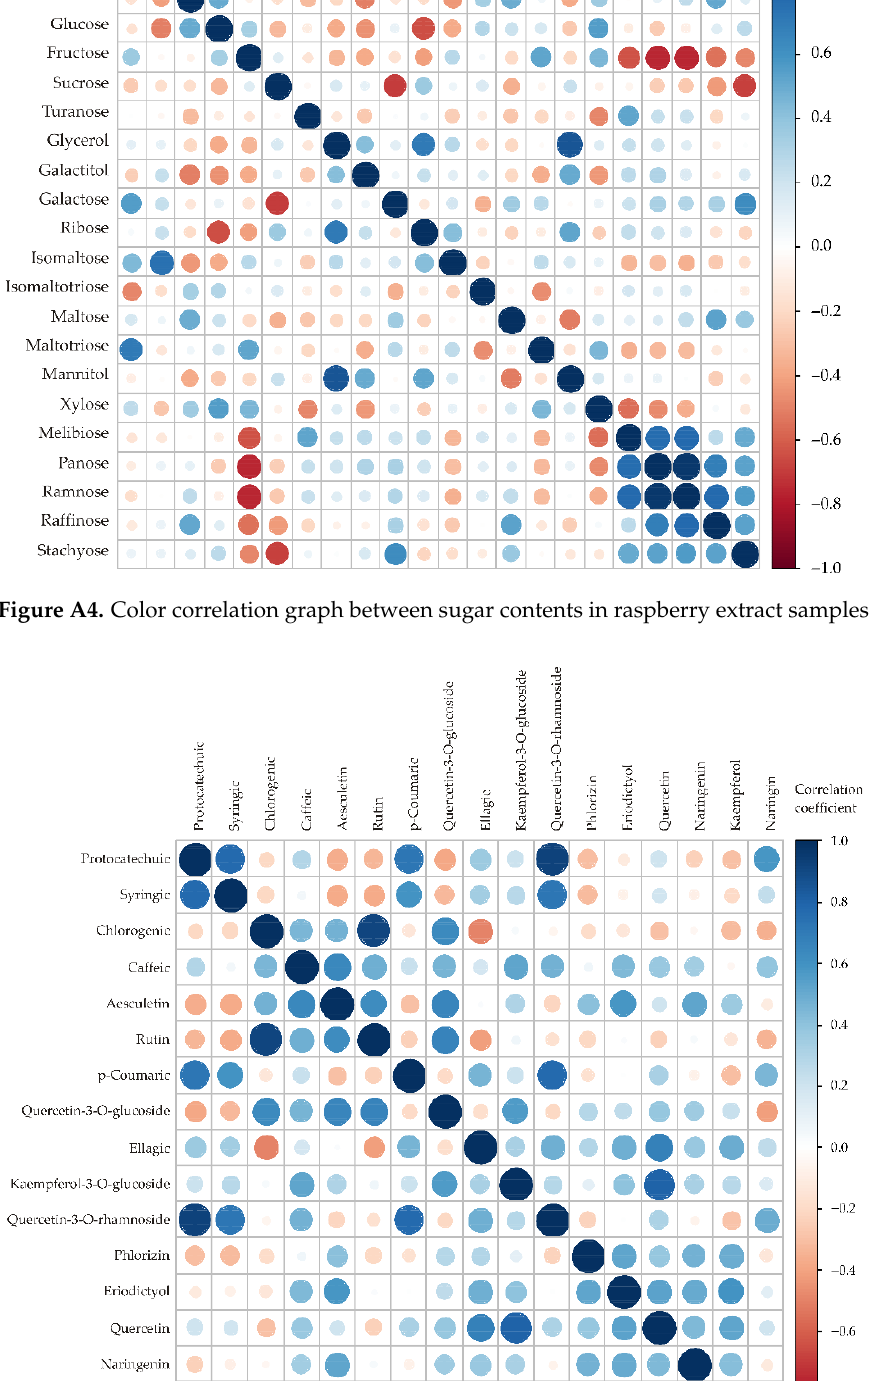
Figure A5. Color correlation graph between phenolic contents in raspberry extract samples.